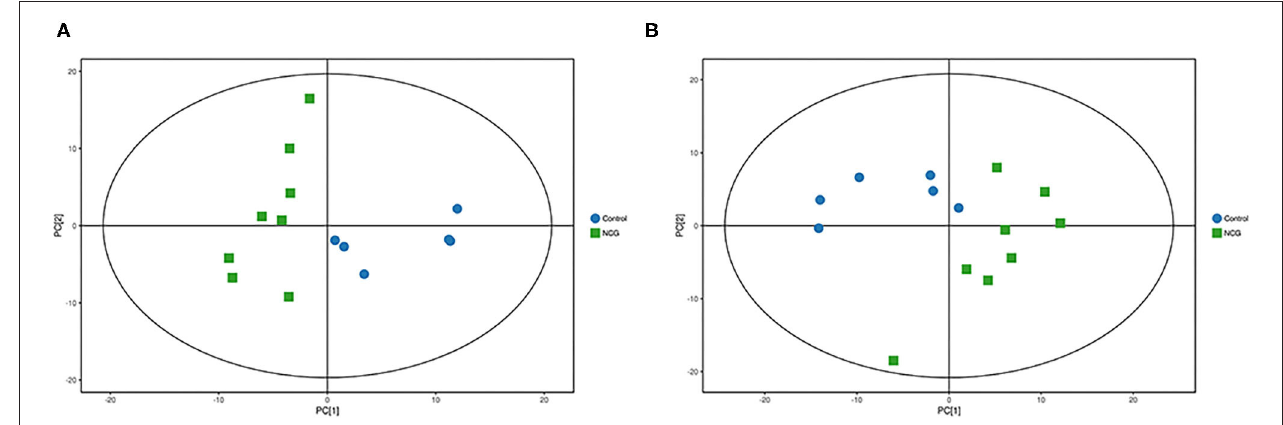
FIGURE 2 | (A) Principal component analysis score plot for the NCG group and CON group plasma samples analyzed in the positive ion mode. (B) Principal component analysis score plot for the NCG and CON group samples analyzed in the negative ion mode. The abscissa PC[1] = first principal component and the ordinate PC[2] = second principal component. The blue circle represents the CON group, and the green square represents the NCG group. The samples are all in within the 95% confidence interval (Hotelling’s T-squared ellipse). The blue circle represents the diet without NCG supplementation (Control, CON group, N = 6), and the green box represents the experimental group with 20 (g/d · head) NCG added to the diet (NCG, NCG group, N = 8).